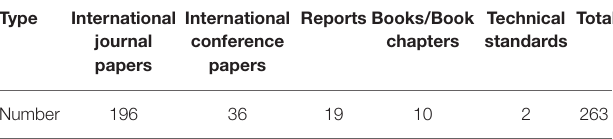
FIGURE 1 | Workflow of the presented review on PI s for bridge QC and management. TABLE 1 | Type of sources analyzed in the present